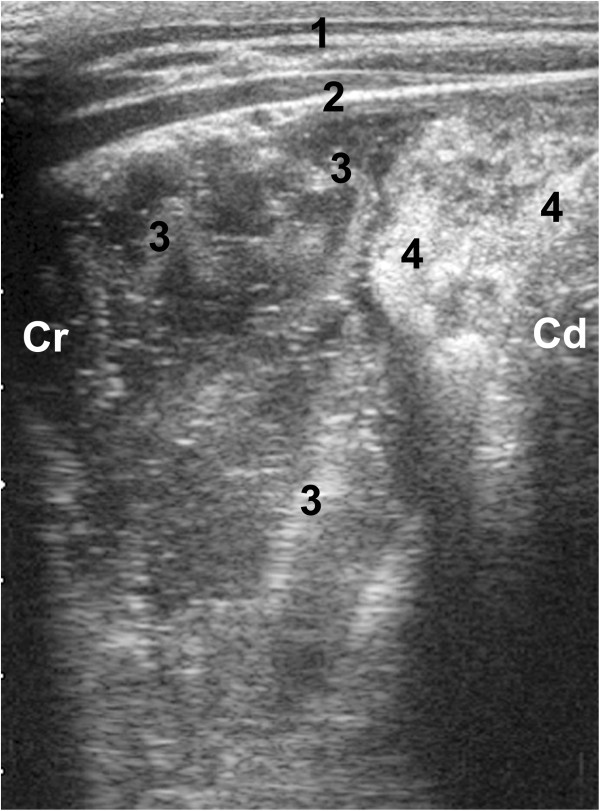
Ultrasonogram of the abomasum. Ultrasonogram of the abomasum of a 17-day-old calf with ruminal drinking syndrome. The 5.0-MHz linear transducer was held parallel to the ventral midline in the left lower abdominal area. The abomasal content appears heterogeneous and echoic, and abomasal leaves are seen as curved structures. 1 Ventral abdominal wall, 2 Abomasal wall, 3 Abomasal leaves, 4 Ingesta, Cr Cranial, Cd Caudal.